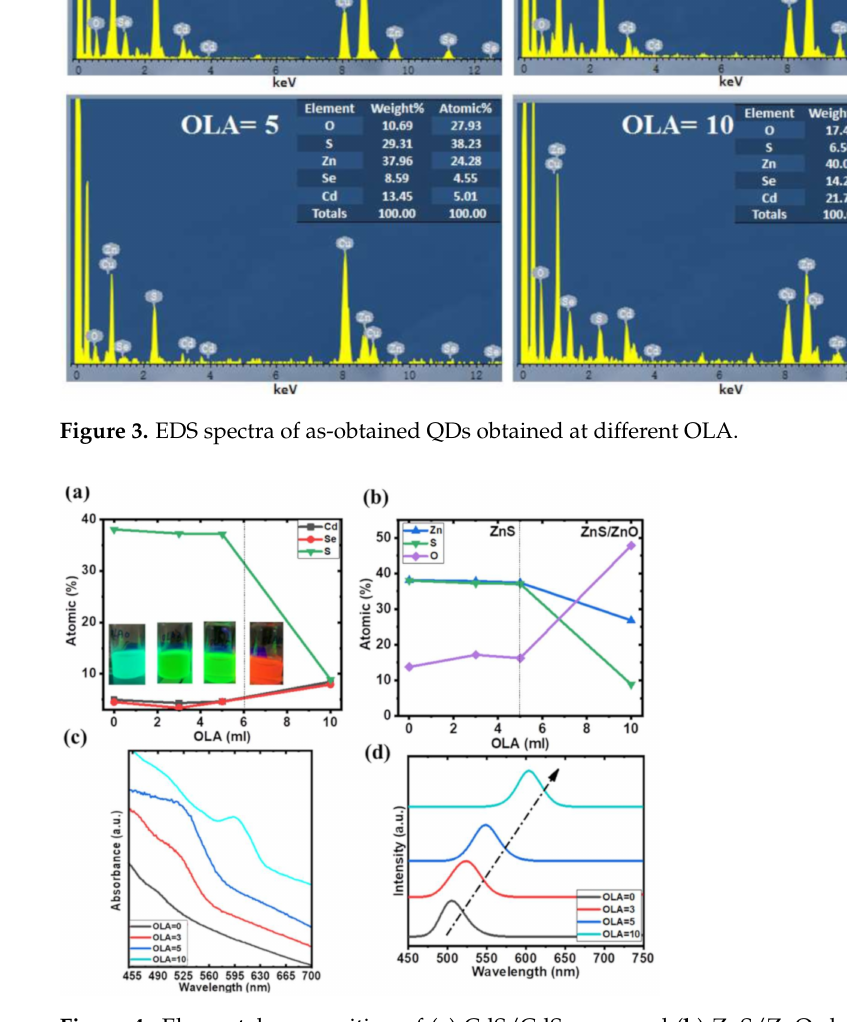
Figure 4. Elemental composition of ( a ) CdS/CdSe core and ( b ) ZnS/ZnO shell QDs obtained at different OLA; ( c ) UV-vis absorption spectra, ( d ) PL spectra of QDs with different OLA